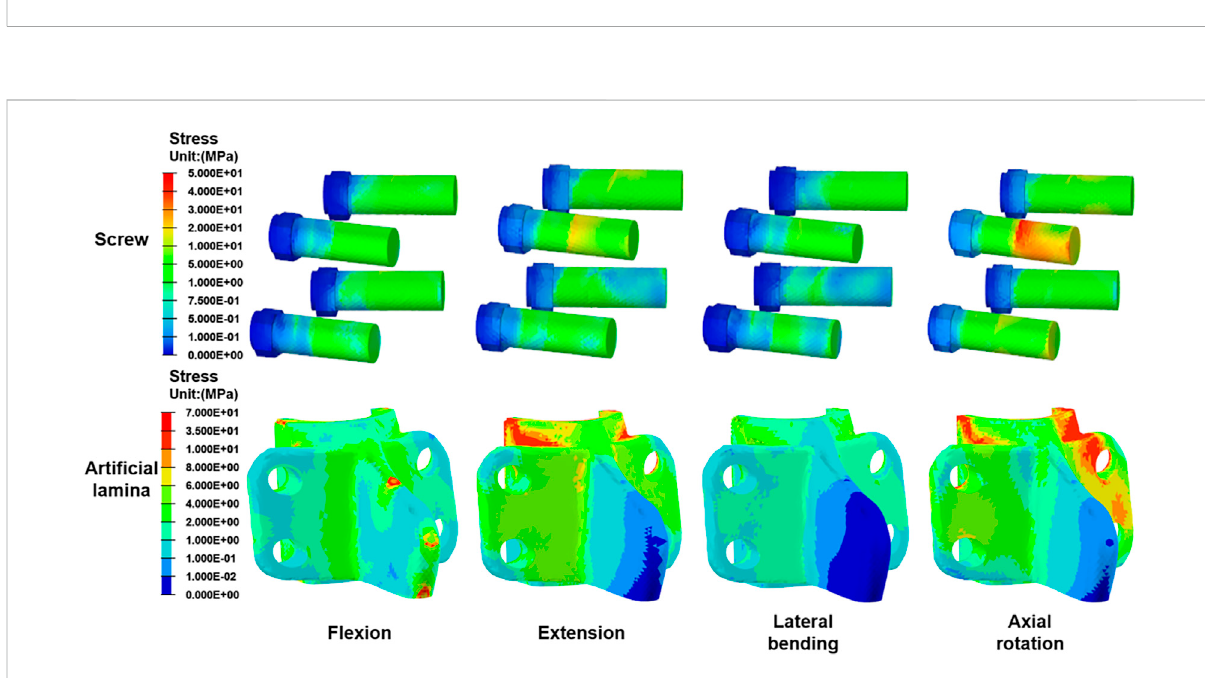
FIGURE 8 The stress distribution of screws and arti fi cial lamina in all